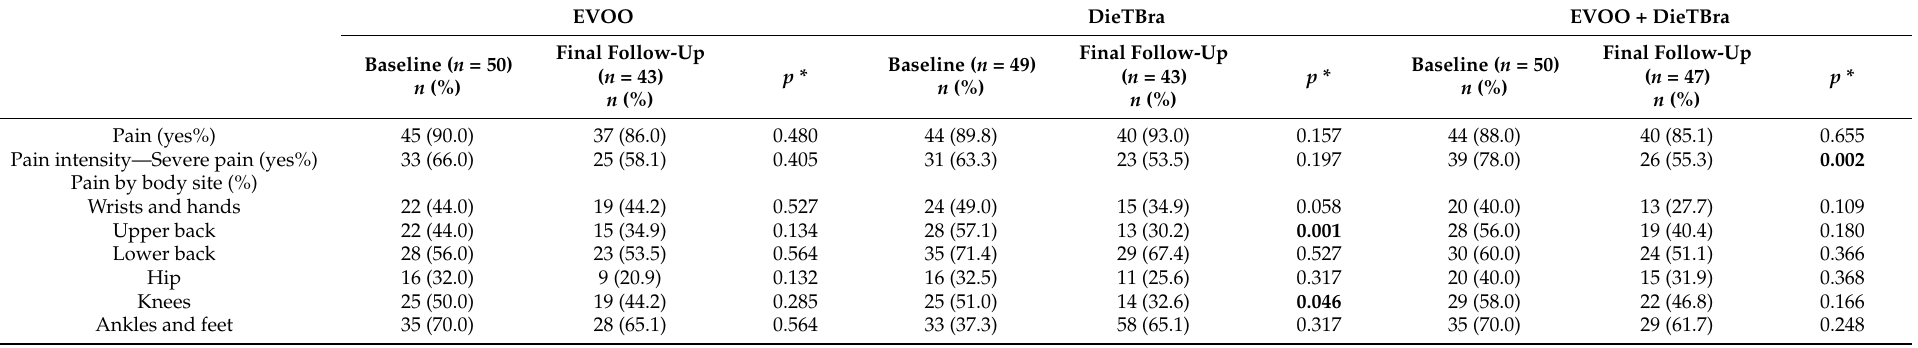
Table 2. Comparison of the prevalence of pain and intensity of musculoskeletal pain at baseline and at the end of the study for each intervention group ( n = 149).